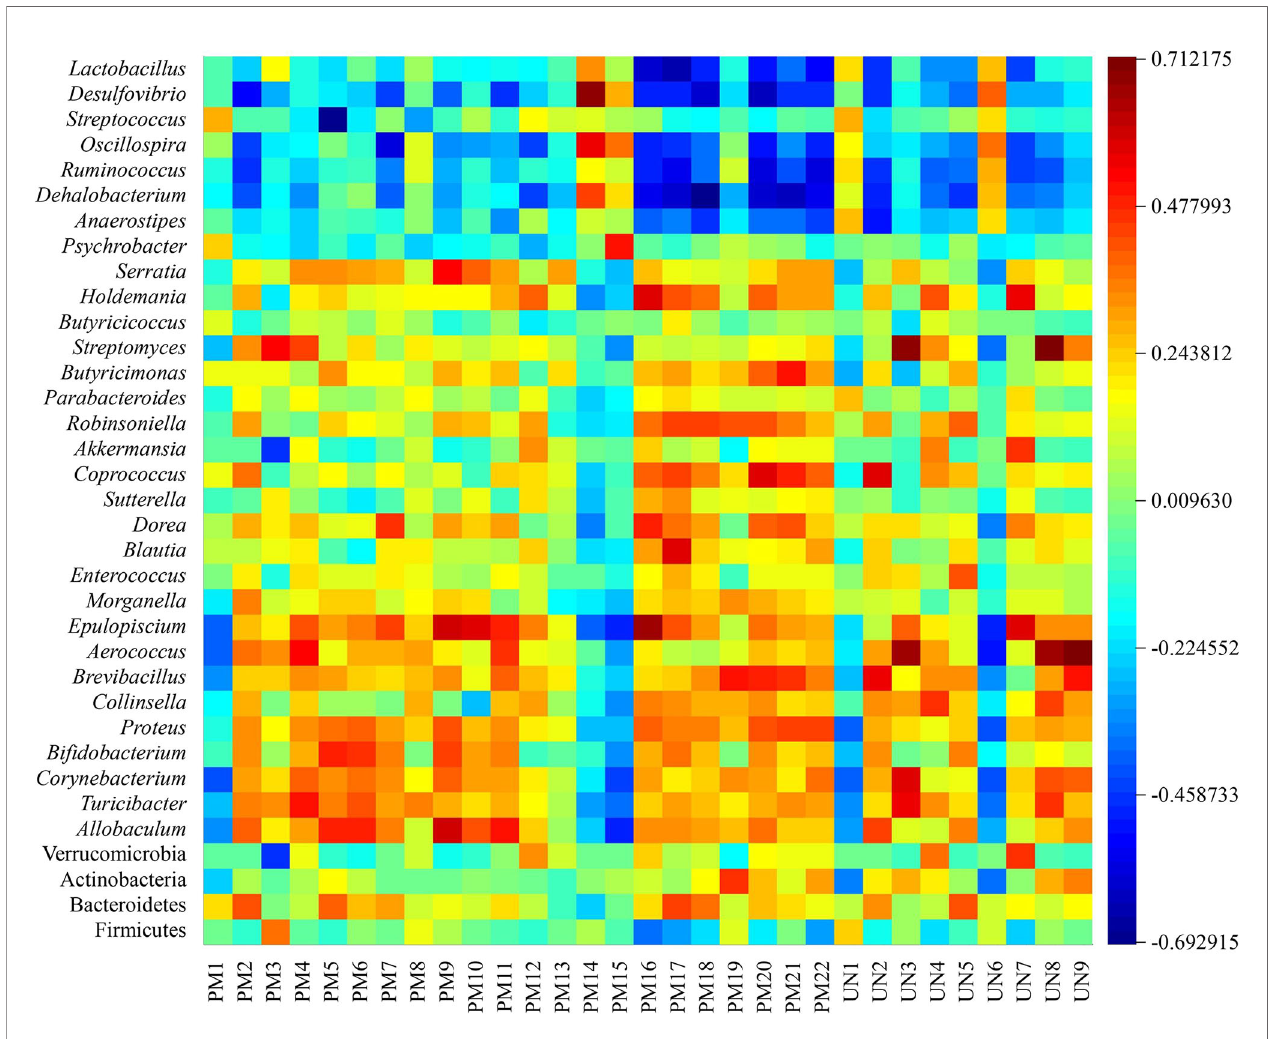
FIGURE 7 | Correlation analysis between potential biomarkers and differential intestinal fl